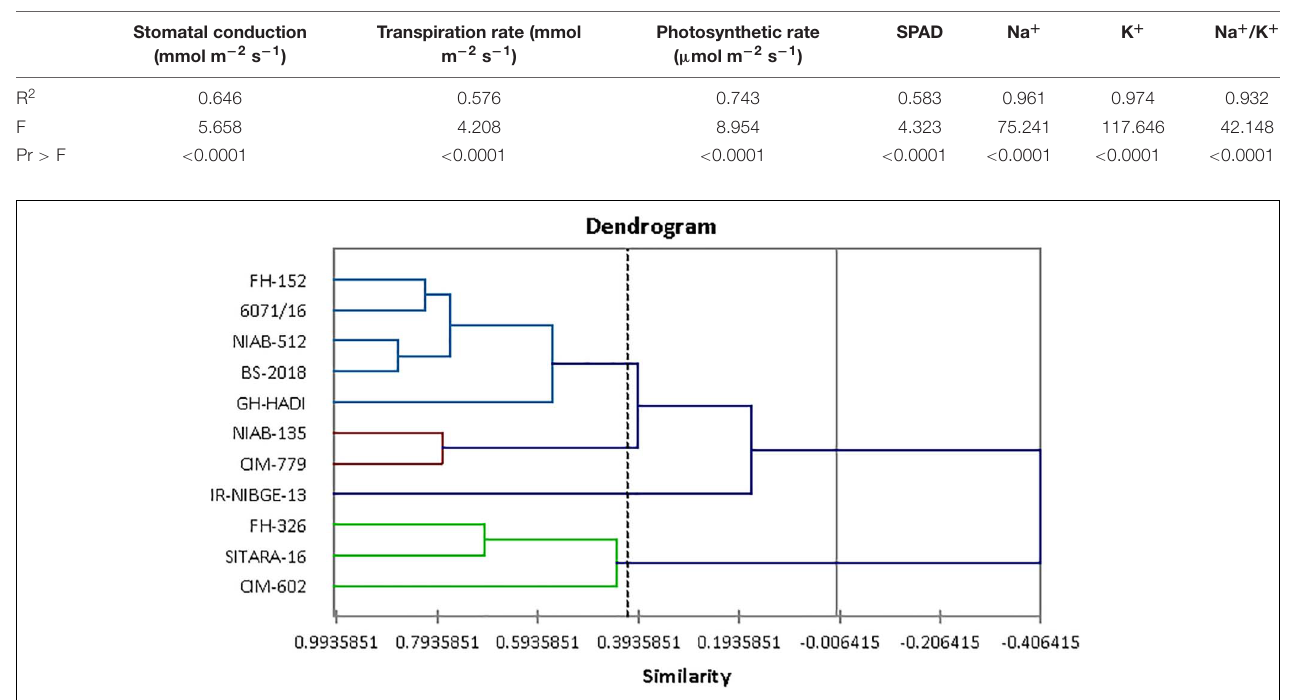
TABLE 12 | ANOVA for physiological parameters.